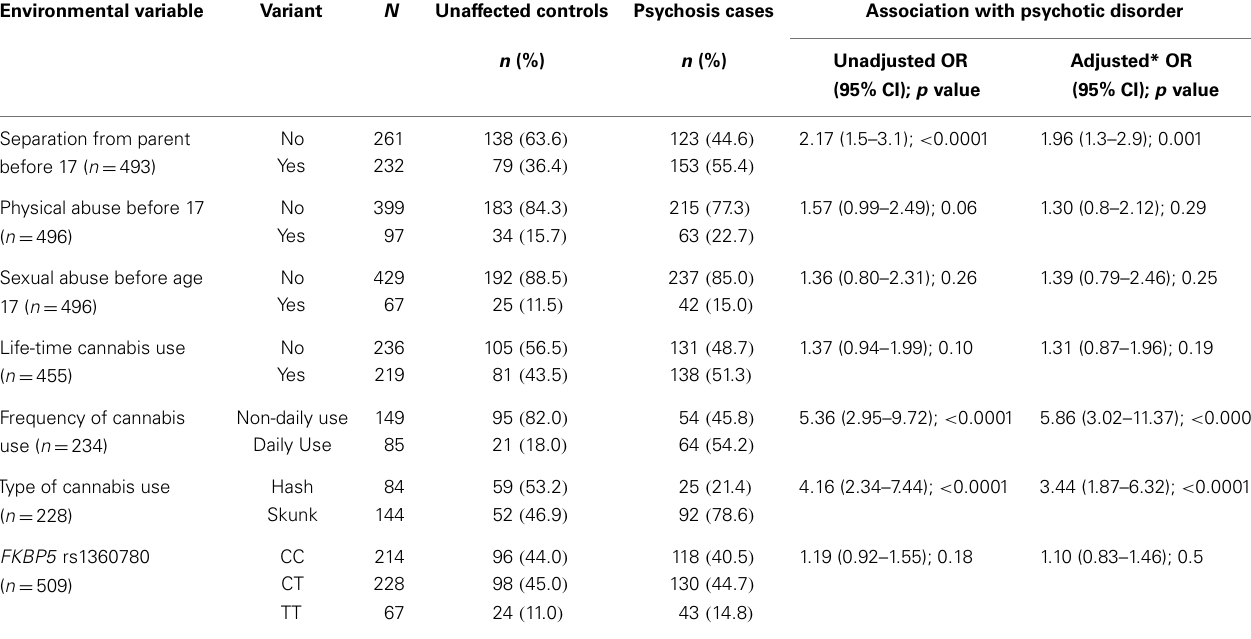
Table 1 | Main effects of environmental risk factors and FKBP5 on psychotic disorder